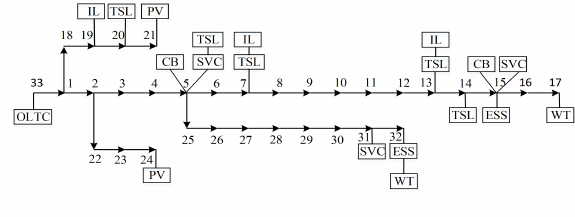
Fig. 2. Schematic diagram of IEEE 33-bus test system